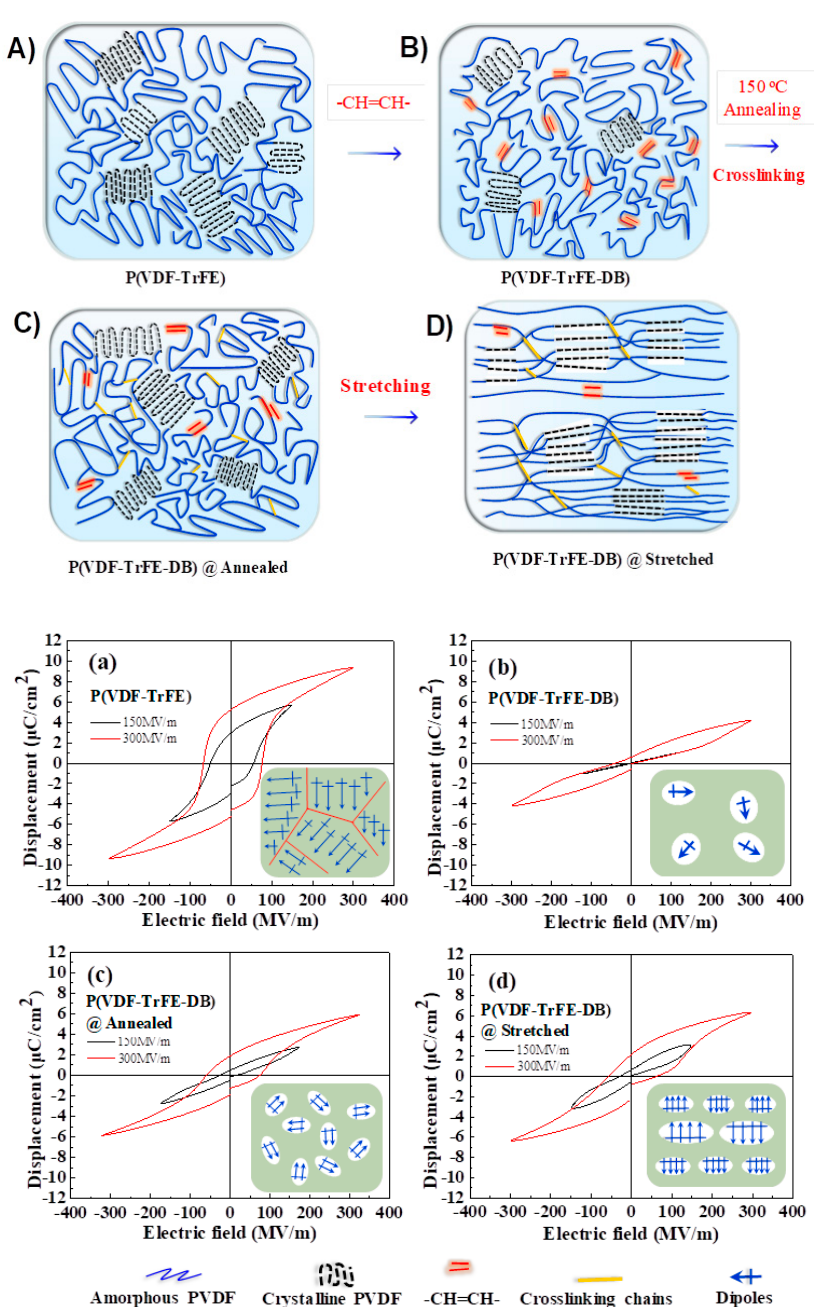
Figure 12. Evolution of ferroelectric phase in P(VDF-TrFE) and P(VDF-TrFE-DB)s under different processing